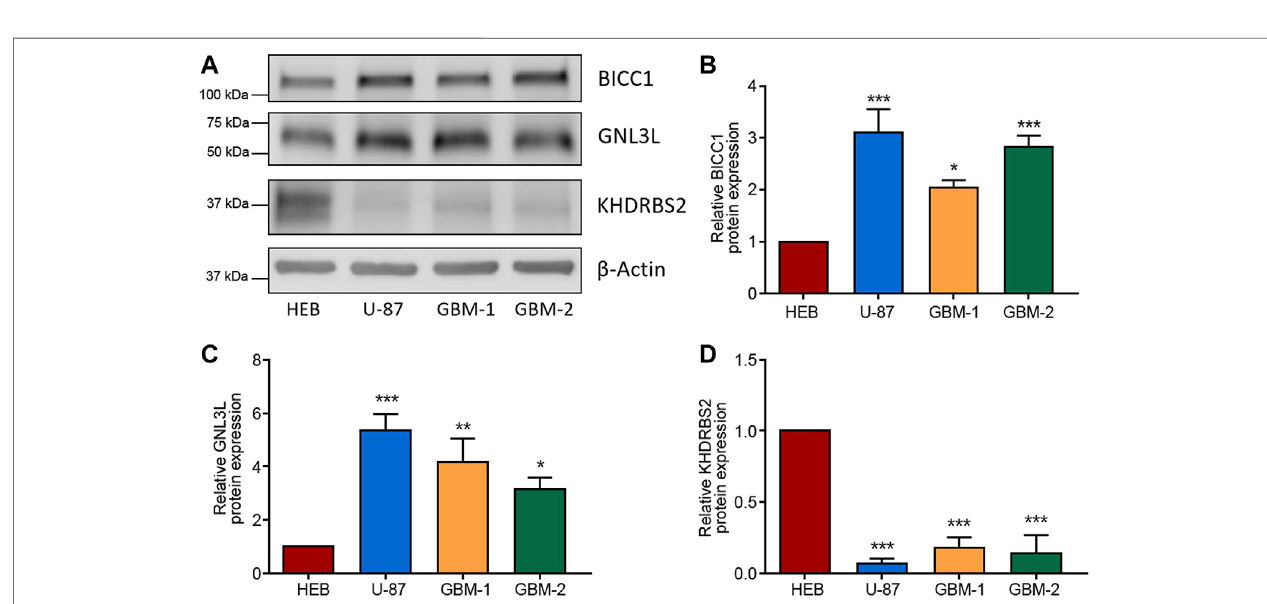
FIGURE9| Validationofthedifferentialexpression ofthe3RBPsinGBMcells. (A – D) Westernblotimages (A) andtherelevantquanti fi cationofBICC1 (B) ,GNL3L (C) , and KHDRBS2 (D) in GBM cell line U-87, primary GBM cells (GBM-1 and GBM-2), and normal glial cell line HEB. The relative expression of target proteins is quanti fi edincomparisonwith β -ActinandnormalizedtothecorrespondingexpressioninHEBcells.Dataareshownasmean ± SEMfrom fi veindependentexperiments, * p < 0.05, ** p < 0.01, *** p < 0.001.